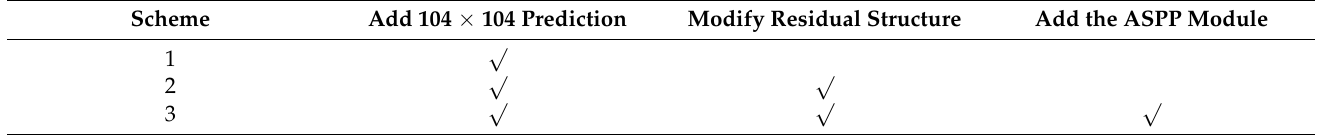
Table 3. The project design.